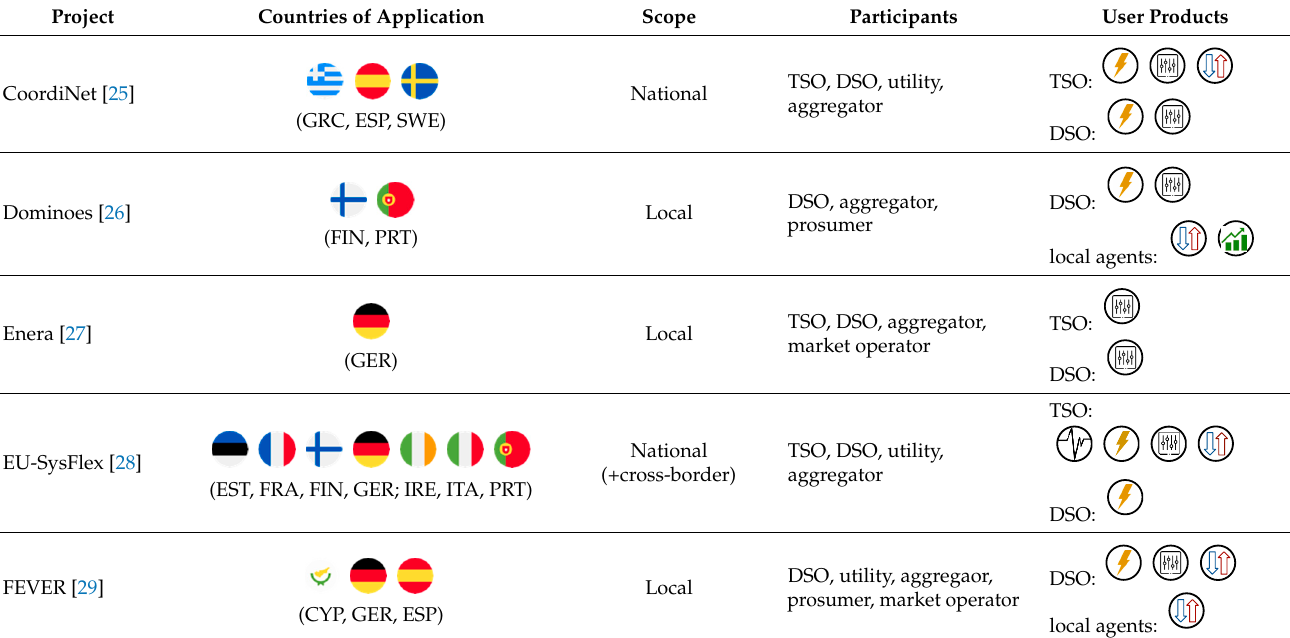
Table 1. Key facts on selected European pilot projects for market integration of flexibility from decentralized energy resources (DERs) (not exhaustive).